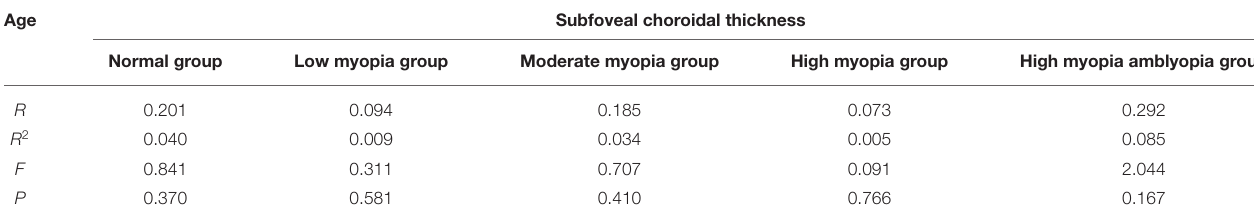
TABLE 6 | Correlation between subfovea choroidal thickness and age in each group.